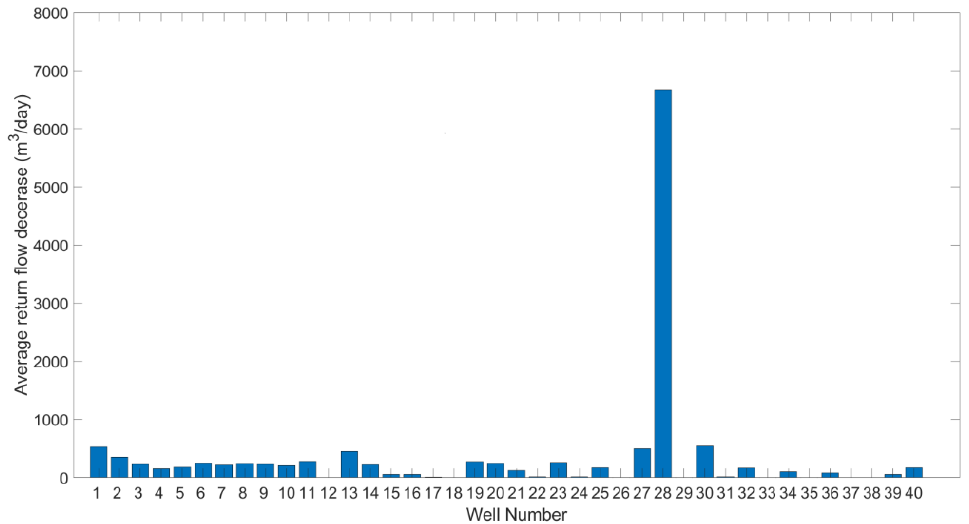
Figure 12. Average daily decrease in groundwater discharge to the South Platte River, based on each recharge pond being removed from the system.